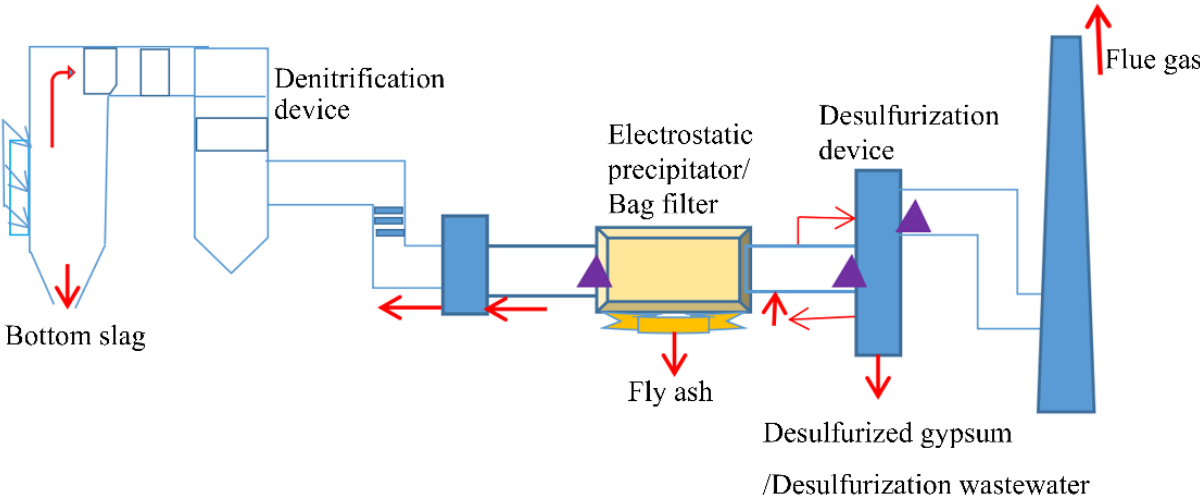
Figure 2. The schematic diagram of the locations of samples (purple triangles indicate the sample location of flue gas).